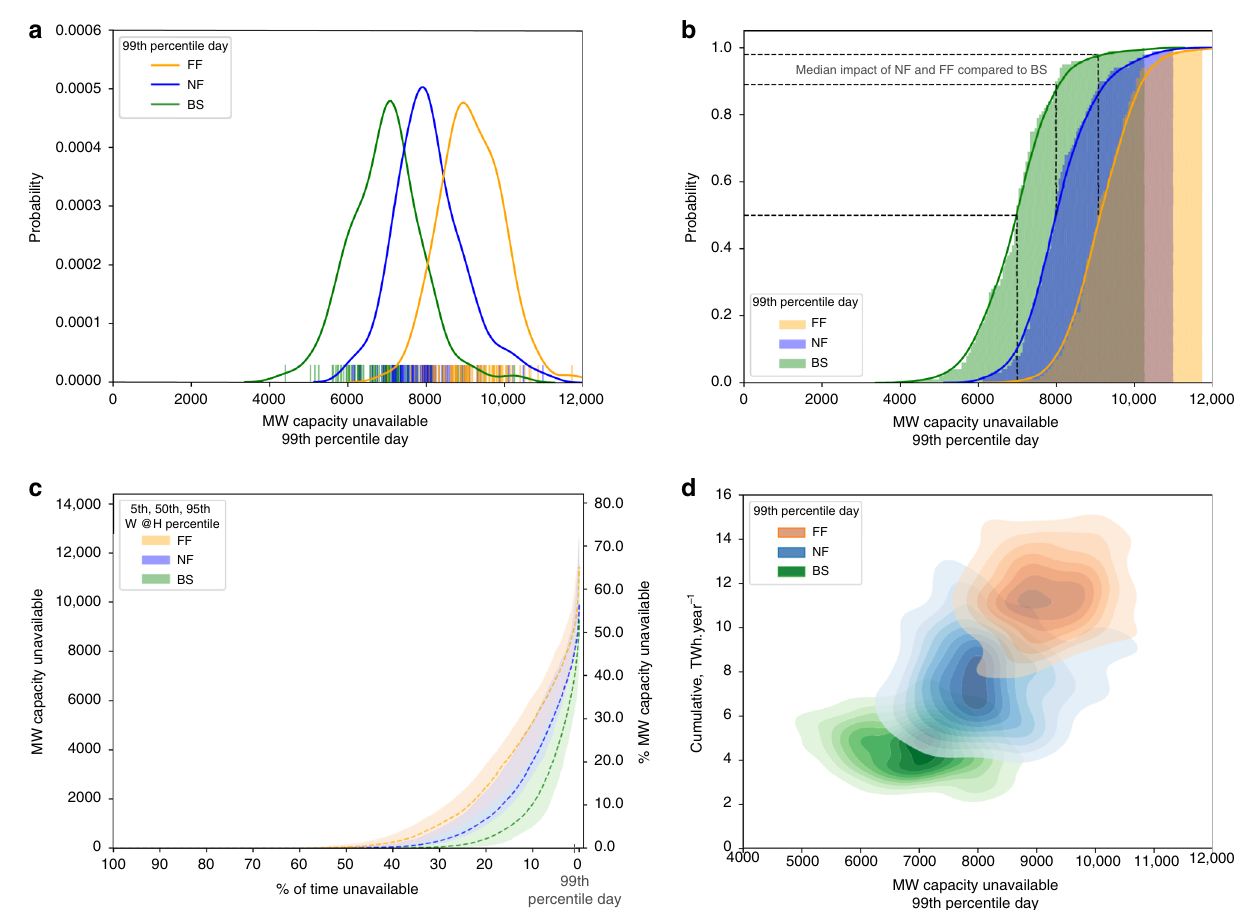
Fig. 3 Impact duration curves and uncertainty of extreme impacts. a Probability distribution of cumulative capacity impacted during an extreme 99th percentile day (i.e. impacts are exceeded only 1% of the time). b Uncertainty across model samples on a 99th percentile day. c Duration of impact with shaded uncertainty ranges (5th – 95th percentiles) across the three climate scenarios compared reveal that accumulated capacity unavailability, through time, can be substantial. d Gaussian kernel density combining data from b and c showing the bi-variate distribution for extreme impact days ( x -axis) and cumulative impact duration ( y -axis), clearly increasing in severity on both axes.